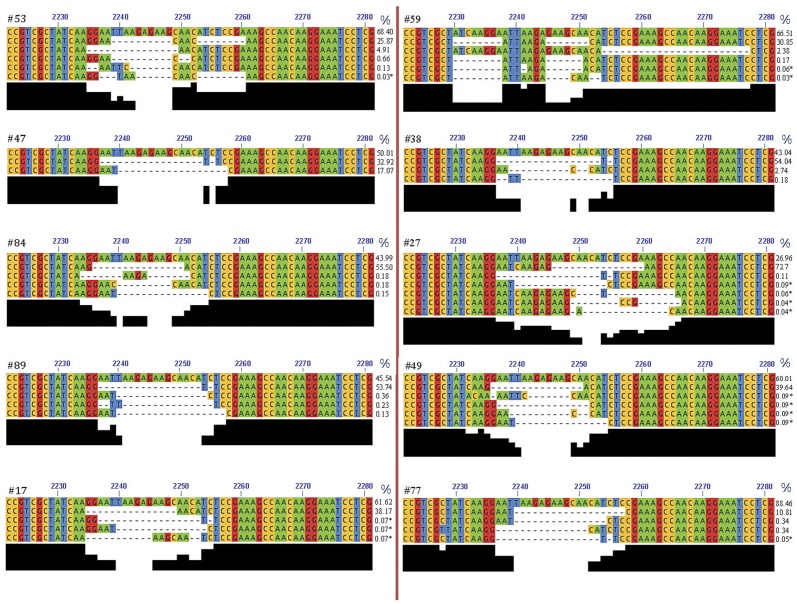
Examples of subpopulations of EGFR deletions at exon 19.The Figure reports 10 selected cases of tumors (#53, #59, #47, #38, #84, #27, #89, #49, #17, #77) showing subpopulations of EGFR deletions at exon 19. In each case the first line corresponds to the wild type sequence. The different bases are highlighted by different colours. Deleted bases are reported as dashes. The black bars under the sequences indicate the consensus for the different bases involved in deletions. On the right of each case is reported the percentage with which the wild type and deleted molecules were present in tumor DNA. The number (N) of sequences obtained in each case were as follow: #53 (N = 6.484), #59 (N = 5.835), #47 (N = 5.629), #38 (N = 4.776), #84 (N = 2.641), #27 (N = 4.389), #89 (N = 3.855), #49 (N = 2.172), #17 (N = 2.856), #77 (N = 3.526). Cases carrying subpopulations in less than 0.1% of the DNA molecules are labeled with an asterisk.